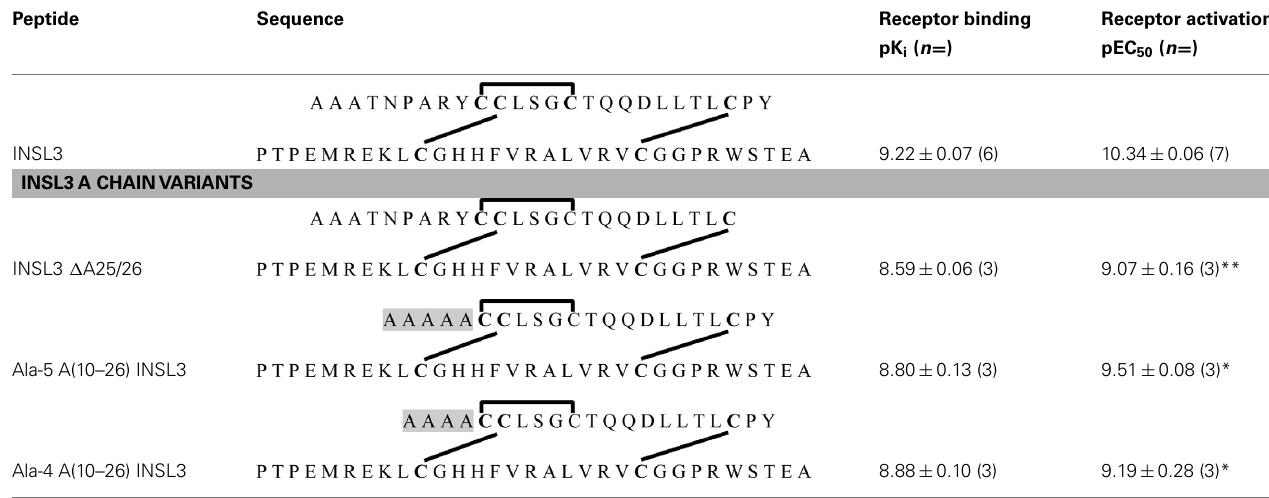
Table 2 | Sequences and receptor binding affinities (pKi) and receptor activation (pEC50) activities of INSL3 and INSL3A chain variants. Peptide